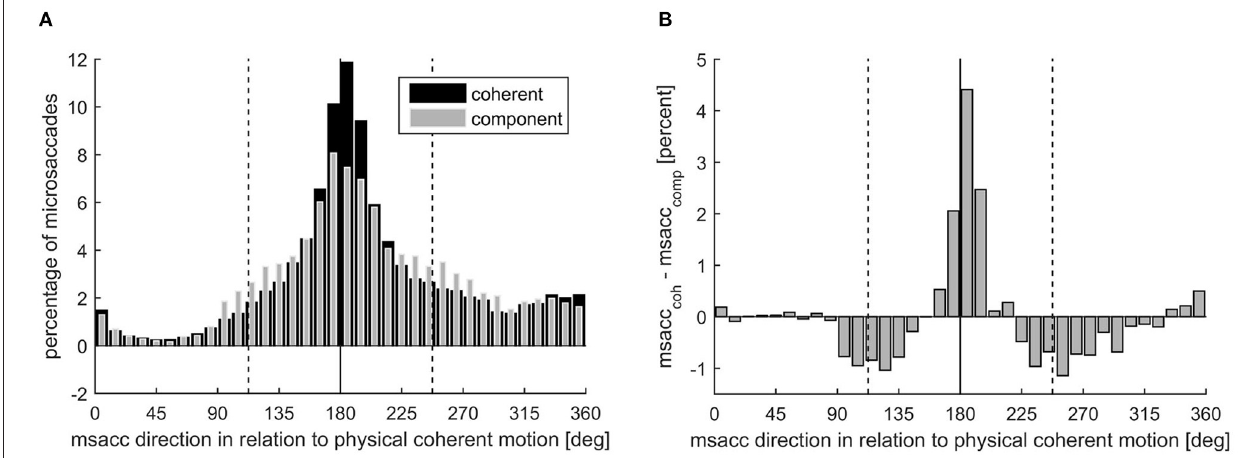
FIGURE 5 | (A) Microsaccade direction presented as microsaccade number in percent during coherent (black) and component motion (gray) perception, separately. The solid line marks the opposite direction of the coherent motion, while the dashed lines mark the opposite directions of the component motions. (B) Microsaccade direction presented as the difference in microsaccade number during coherent motion and component motion perception in